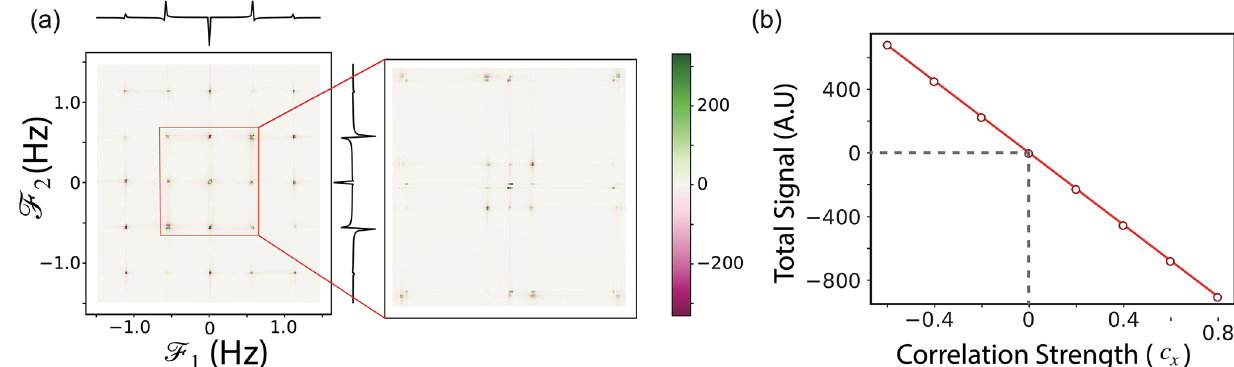
0.8 , c y 4 Hz , 0 , (cid:31) ( xx ) 0 , c z = − = = =